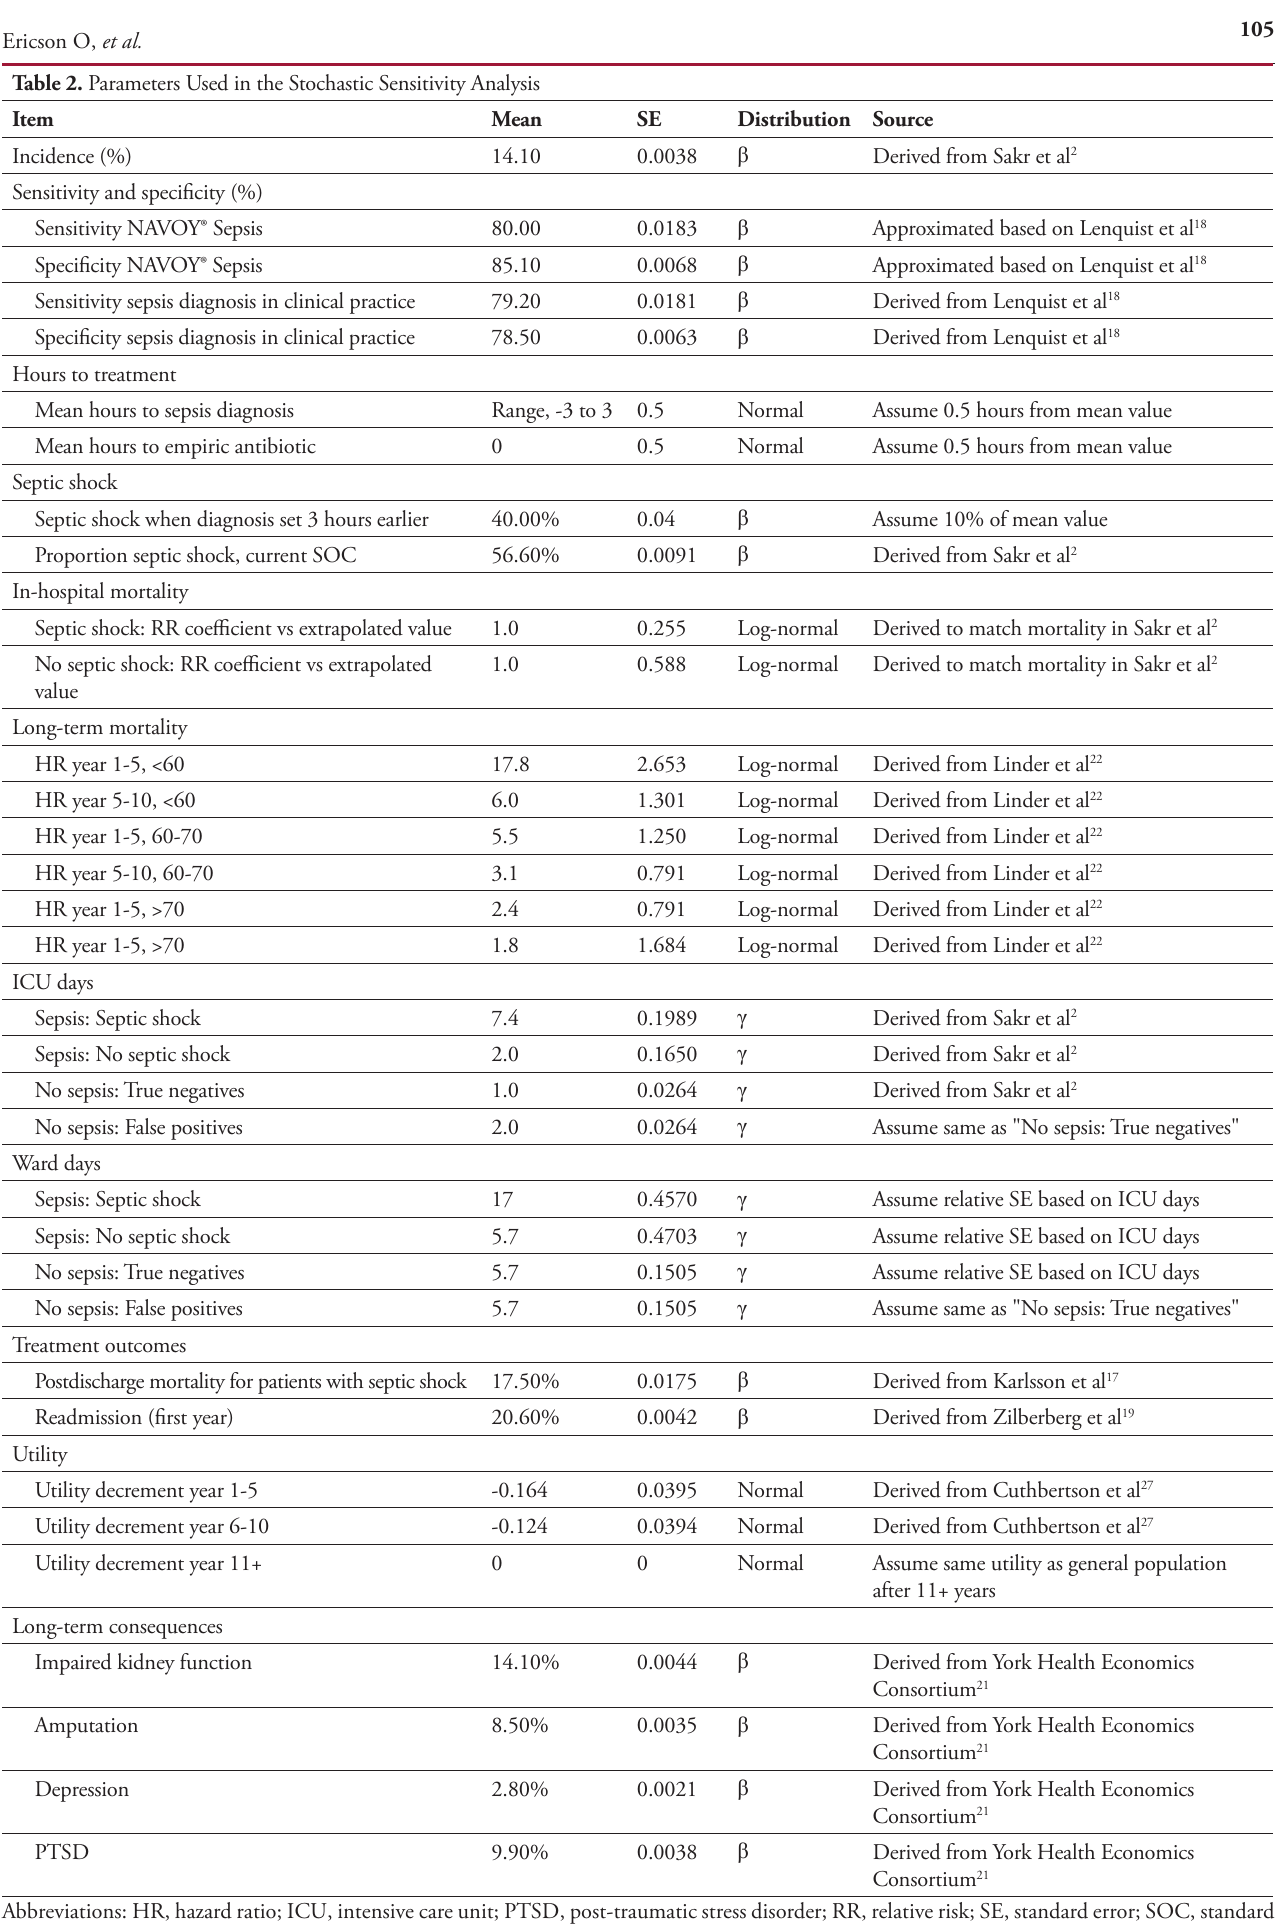
Table 2. Parameters Used in the Stochastic Sensitivity